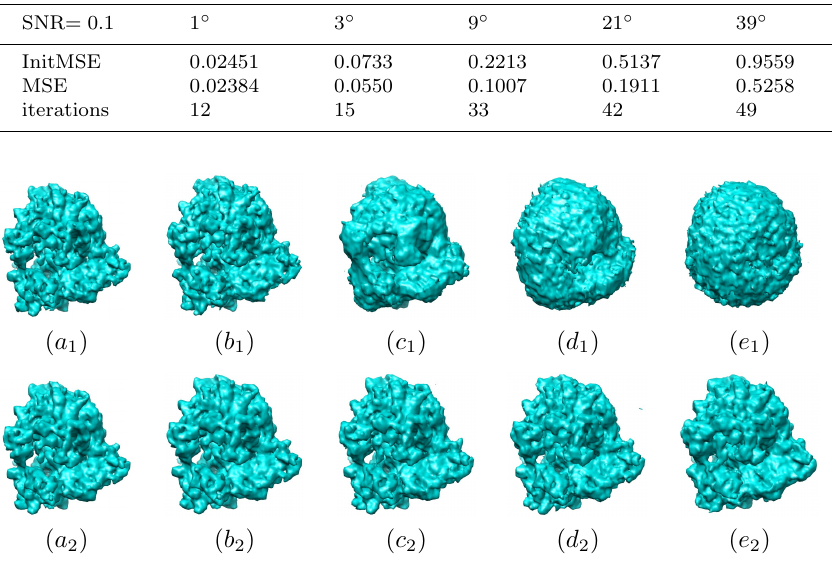
Figure 5. The comparisons of the initial maps (first row) and the refinement maps (second row) using the proposed algorithm for the noisy images. The maps from column (a) to column (e) show the cases for 1 ◦ , 3 ◦ , 9 ◦ , 21 ◦ and 39 ◦